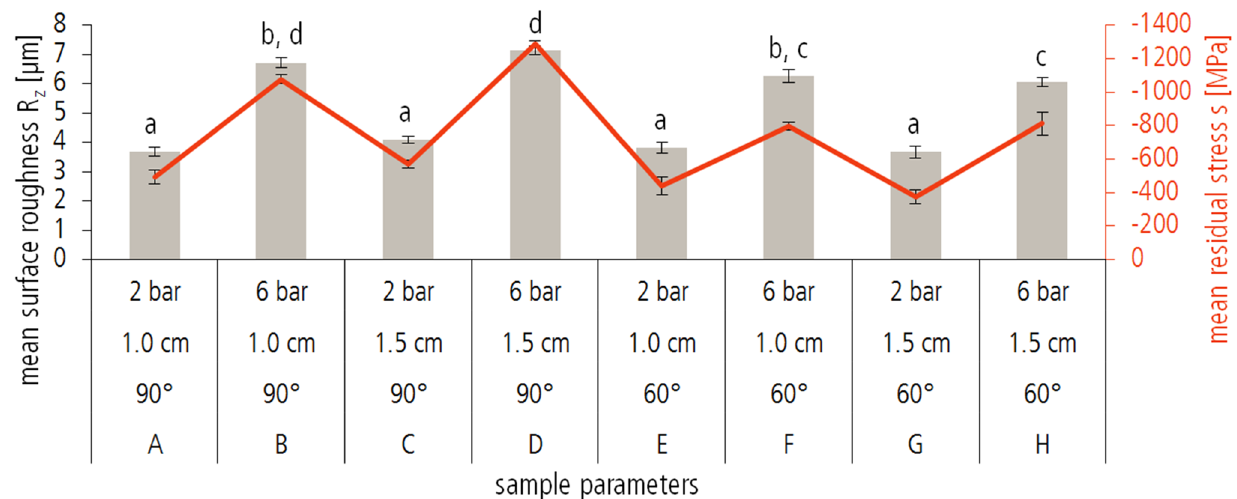
( p > 0.05) between their mean R values. Without sandblasting the z surface roughness R